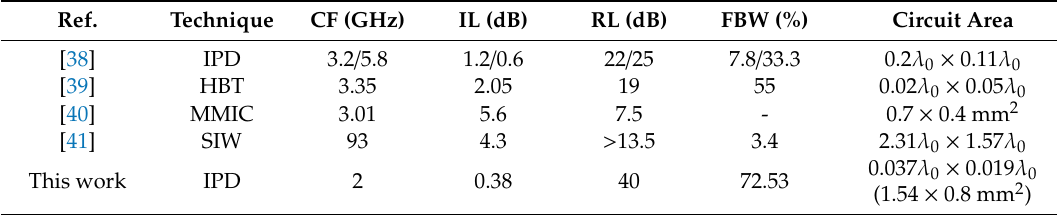
Table 4. Comparisons with other works using GaAs-based technology